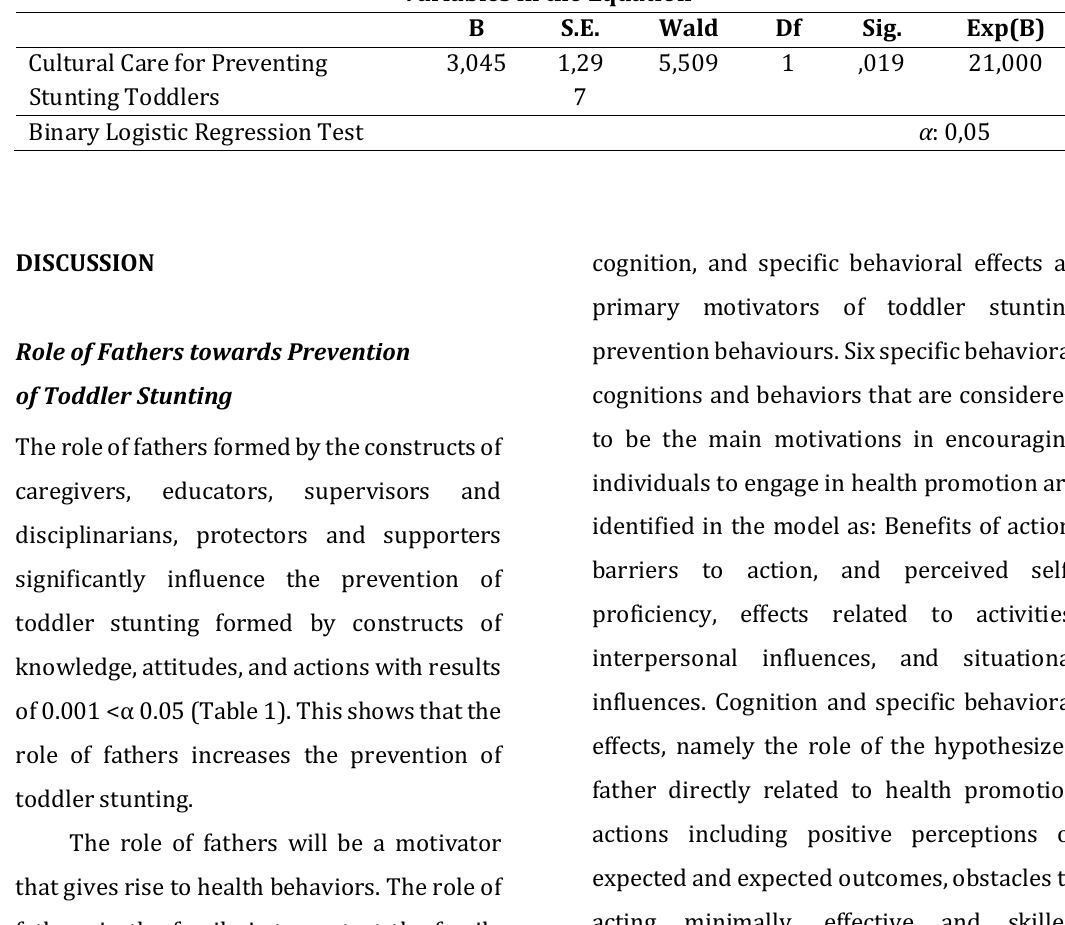
Binary Logistic Regression Test Results of Cultural Care for Preventing Stunting Toddlers Variables in the